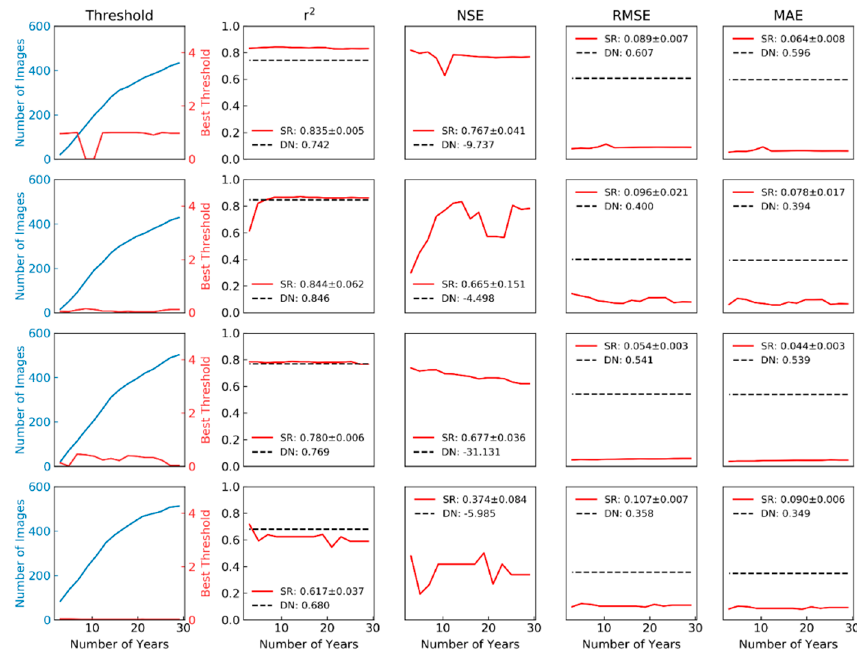
Figure 11. Effect of the length of Landsat time series on the identification of NIR thresholds and the quality of the NDVI correction. Plots in rows 1-4 show the effects at sites 1-4 respectively. Columns 1- 5 show responses of the number of images, coefficient of determination, Nash–Sutcliffe efficiency, root mean square error, and mean absolute error, respectively.